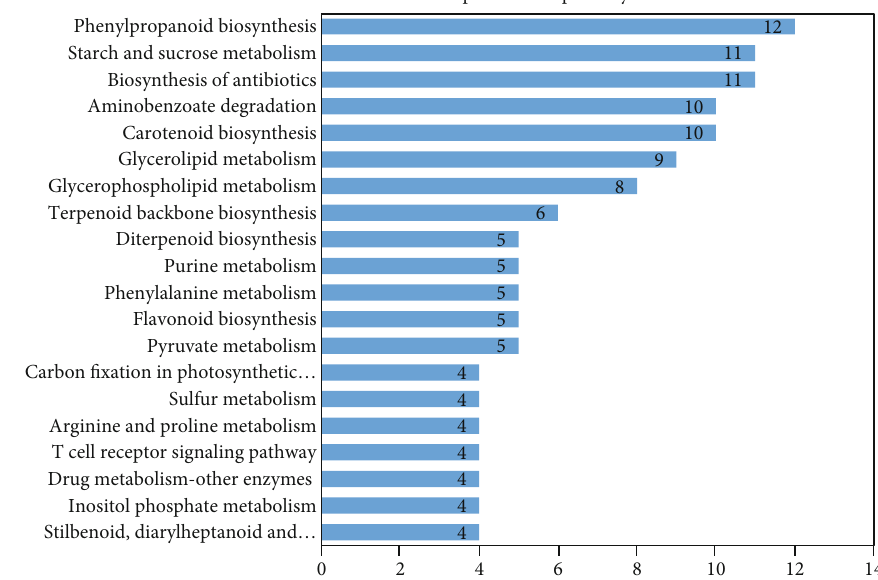
Figure 3: Top 20 upregulated KEGG pathways in C. tetragonoloba under drought stress.